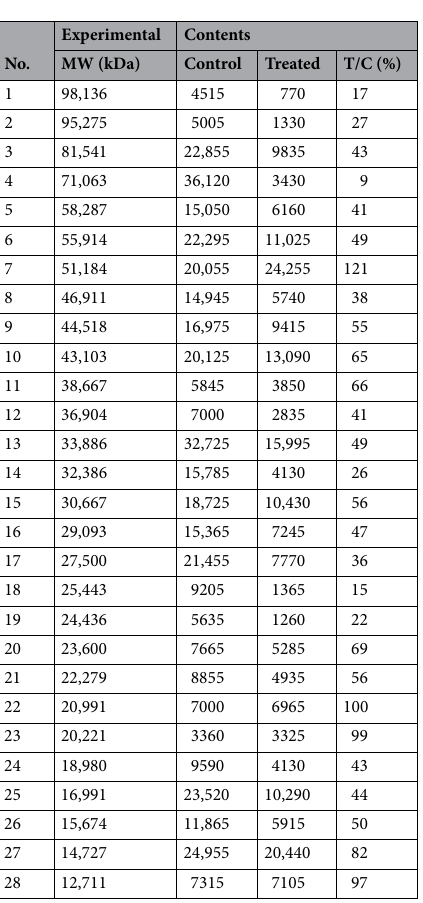
Table 1. The SDS-page analysis of biofilm bacterial proteins after Alcalase